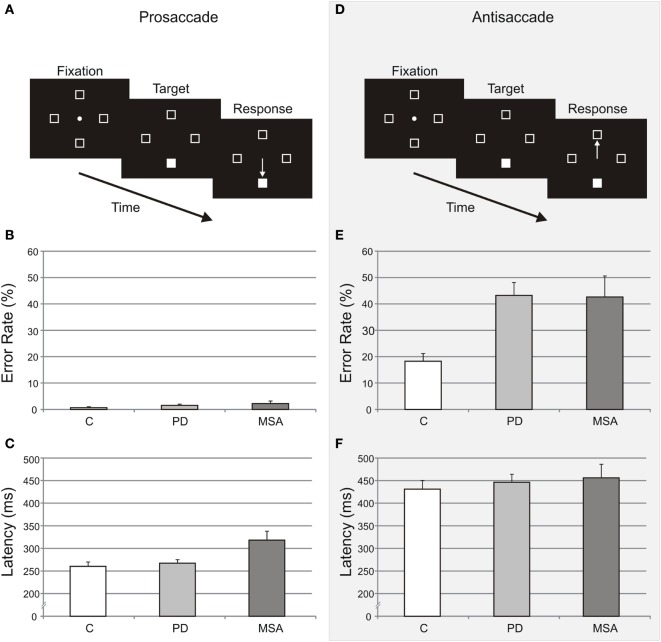
Prosaccade and antisaccade tasks, error rates, and latencies. The prosaccade (A) and antisaccade (D) tasks are illustrated as a function of time. Error rates (unadjusted mean ± SE) for the prosaccade (B) and antisaccade (E) tasks are shown as percentages of the total number of trials for all groups. Latencies (unadjusted mean ± SE) for the prosaccade (C) and antisaccade (F) tasks are shown for all groups. Control (C), Parkinson’s disease (PD), and multiple system atrophy (MSA) subjects are illustrated in white, light gray, and dark gray, respectively.